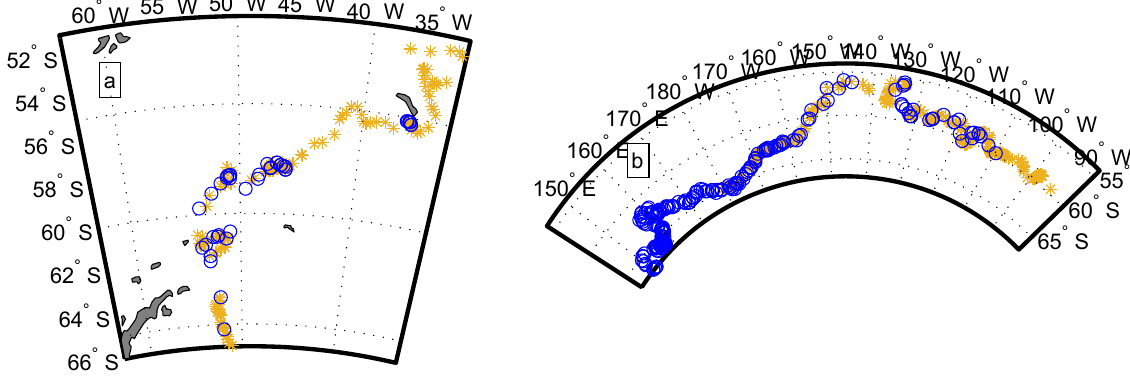
Figure 2. Sampling of B17a (a) and C19a (b) icebergs by MODIS (beige stars) and altimeters (blue circles).